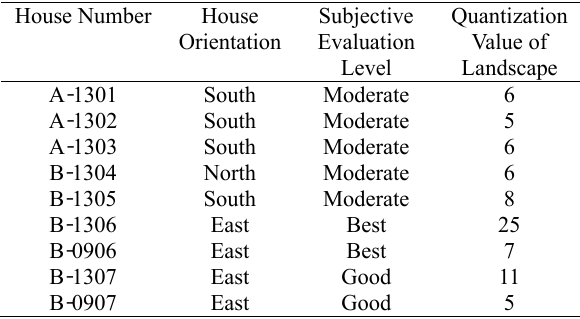
Table 3. Correlation Table of Landscape Analysis